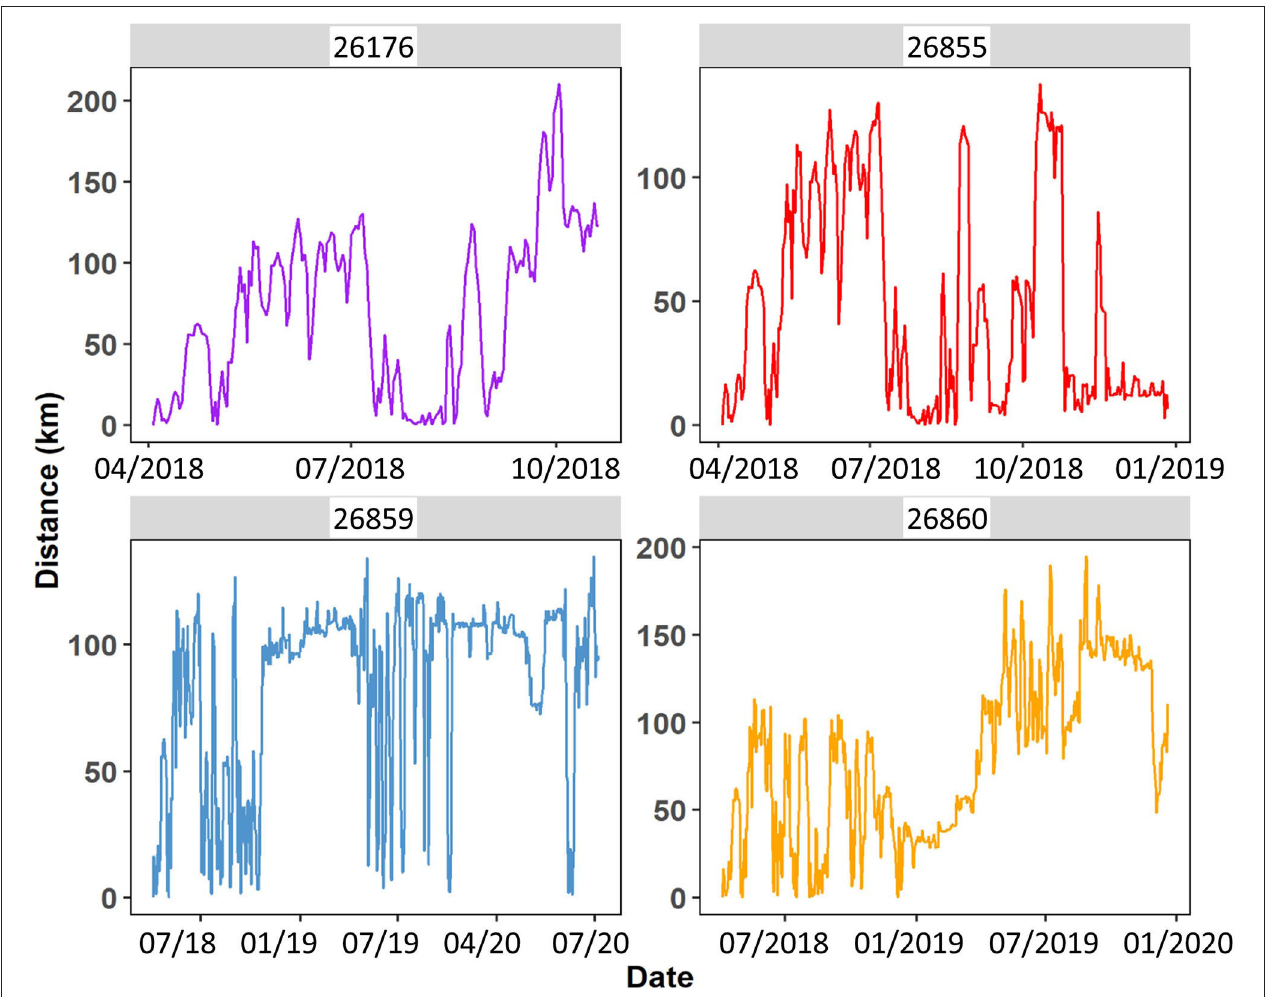
FIGURE 5 | Distance to pre-release enclosure by four reintroduced kulan in the Torgai region April 2018 until July